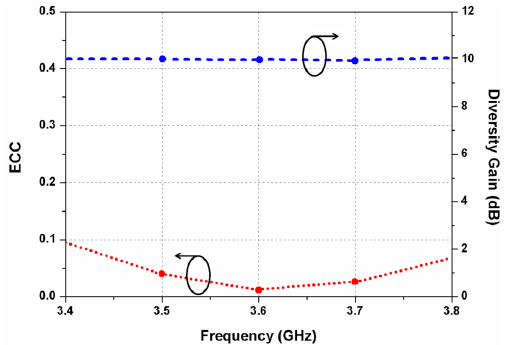
Figure 11. Measured ECC and DG of the dual CP MIMO